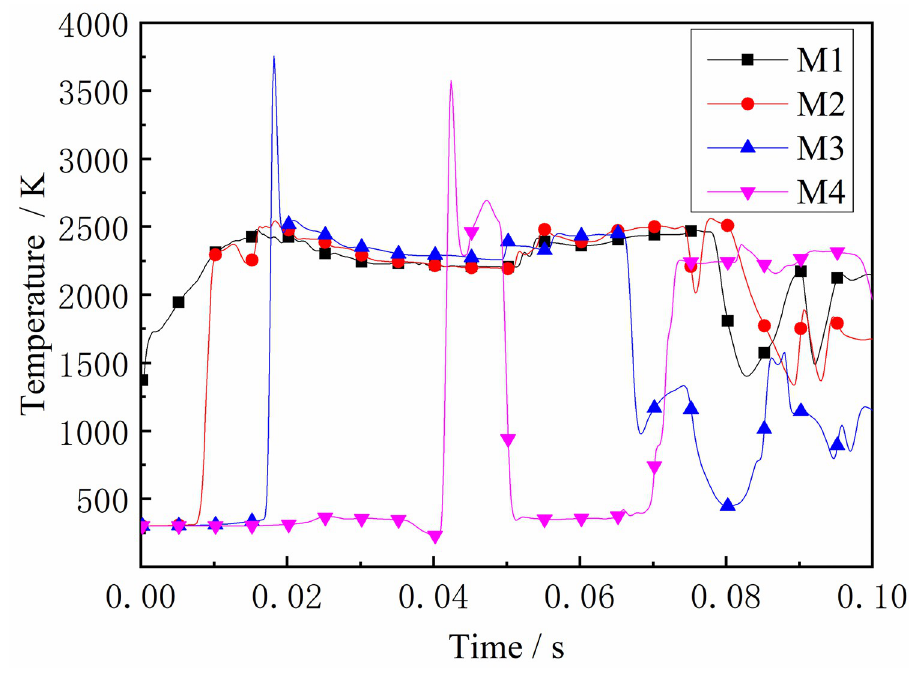
Fig 20. Temperature—Time curves at the monitoring point M1-M4 (gas concentration is 9.5%).